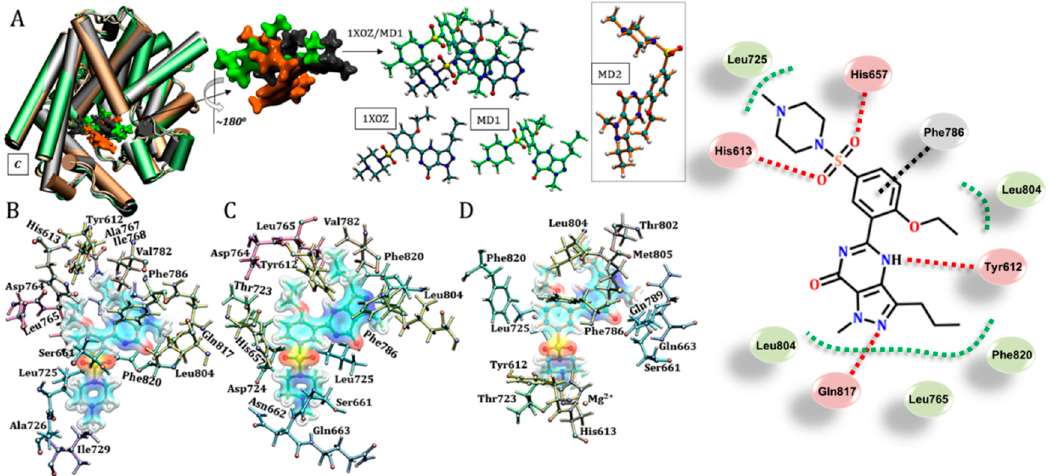
Figure 3. Stabilization of sildenafil by specific amino acid residues in the catalytic pocket, considering the protein structures of 1XOZ and MD1 from MD simulations. ( A ) Shows the overlays of the poses considering the di ff erent structures, highlighting conformational similarity between 1XOZ and MD1. ( B ) Residues that stabilize sildenafil considering the crystallographic structure. ( C ) and ( D ) show residues interacting with the ligand considering MD1 and MD2, respectively. Residues were r ≤ 3.0 Å from the ligand. Legend of interactions, red: hydrogen bond (and dipole–dipole); green: hydrophobic; black: π -stacking.